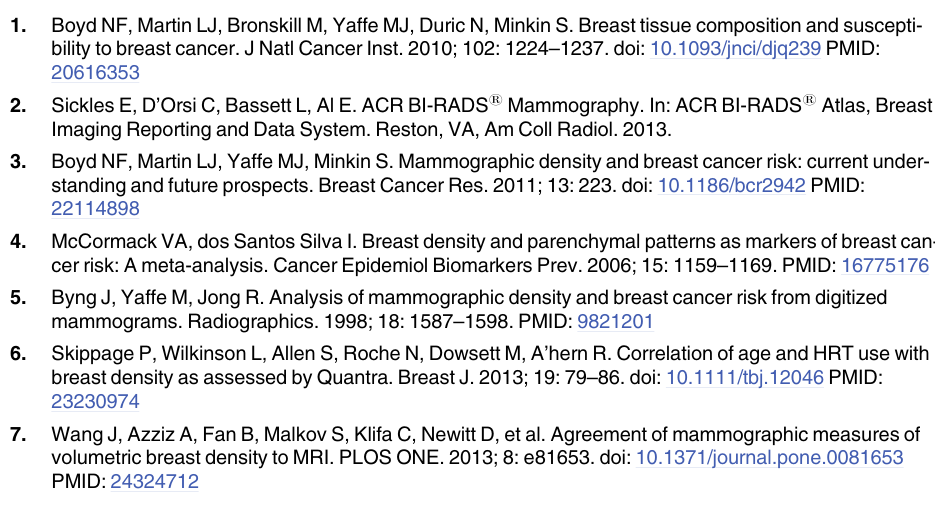
S1 Table. FGT volume, total breast volume and %FGT from Dixon datasets at different weighting in 10 volunteers (right & left spatial resolutions and with different T 1